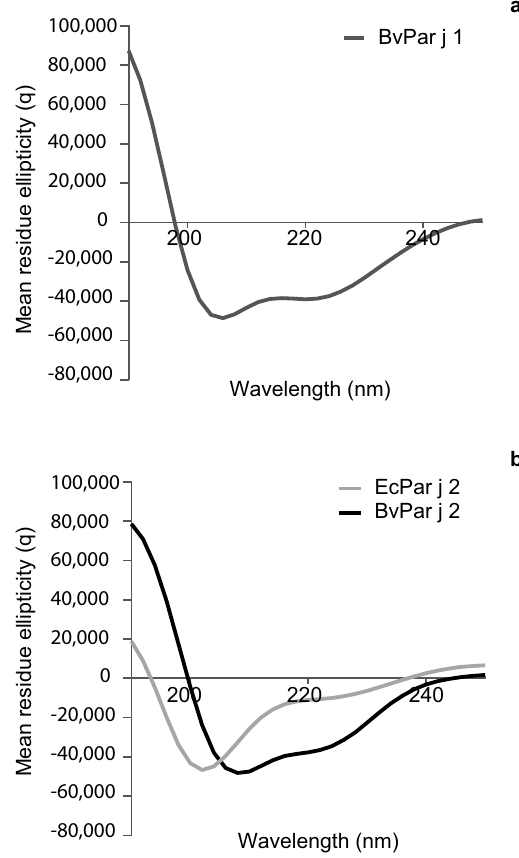
Figure 3. Far-UV circular dichroism analysis of ( a ) BvPar j 1, ( b ) BvPar j 2 (black) and EcPar j 2 (grey). Shown are mean residue ellipticities Θ (y-axes) at the given wavelengths